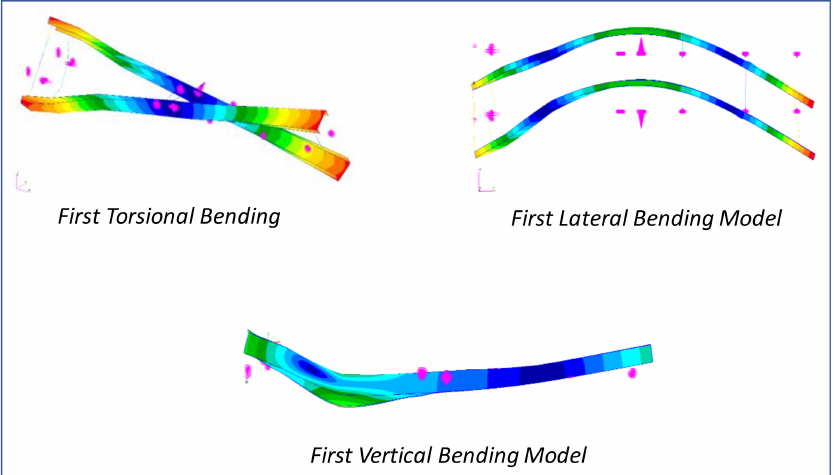
Figure 7. First torsional bending, first lateral bending, and first vertical bending modal